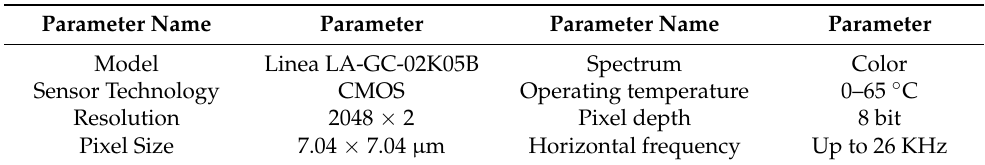
Table 1. Specific parameters of the CCD camera.